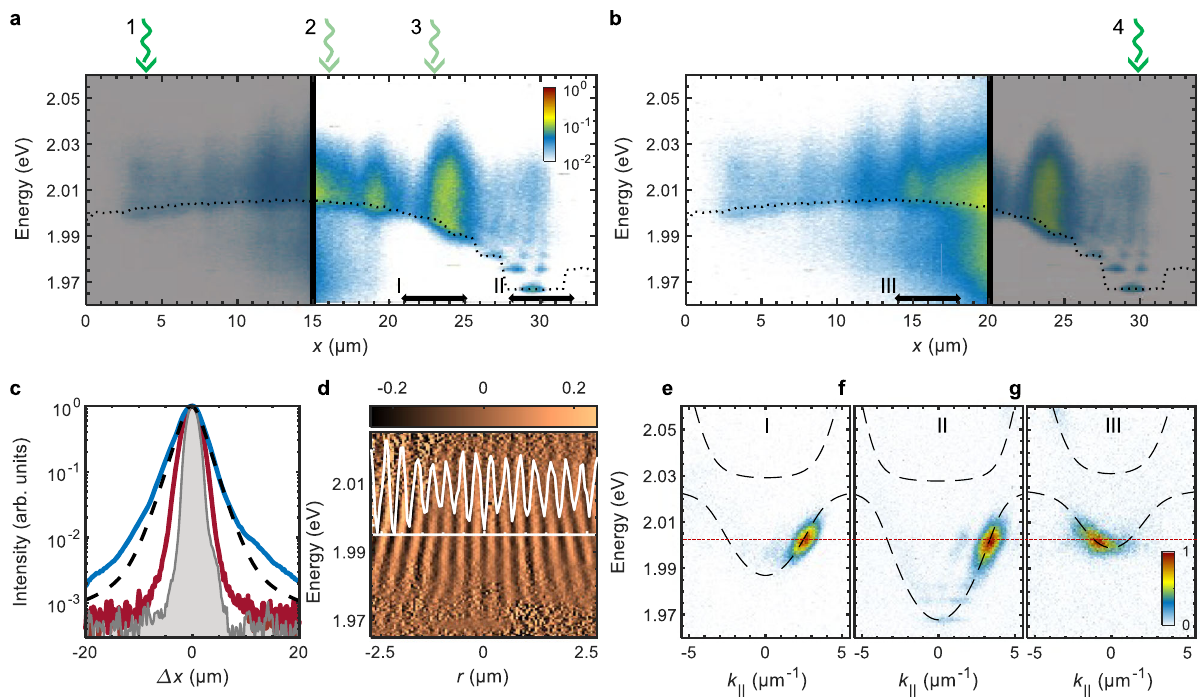
Fig. 4 Long-range polariton transport. a Position-resolved PL spectrum of the polaritons excited in the shaded area at position 1, x = 4 μ m (green arrow), and measured in the clear area at x > 15 μ m. b Position-resolved PL spectrum of the polaritons excited in the shaded area at position 4, x = 30 μ m (green arrow), and measured in the clear area at x < 20 μ m. The outline of the polariton energy at k ≈ 0, obtained by extracting spectral peak position from the signal in Fig. 2b, is marked with a dotted black line. Green (1-4) and black (I-III) arrows mark excitation and detection positions for panels c – g , respectively. c Real-space pro fi le of the laser excitation spot (grey), and the corresponding PL pro fi les of the exciton emission of a monolayer WS 2 on the DBR substrate (red), and polariton emission of the microcavity (blue), when the sample is excited at position 2. The black dashed line is the modelled PL pro fi le of the thermal polariton gas at T = 300 K (see Supplementary Fig. 4). d Normalised, spectrally resolved interferogram of the travelling polaritons in the region II, when the sample is excited at position 3. The unit of the colour bar is fringe visibility. The superimposed line plot (white) shows the normalised interference fringes at E = 1.995 eV in the range [ − 0.2, 0.2]. e , f Normalised momentum-resolved PL spectra in the detection regions ( e ) I and ( f ) II, when the sample is excited at position 2. g Normalised momentum-resolved PL spectrum in the detection region III, when the sample is excited at position 4. The spectra in e – g are measured with different spectrometer settings and acquisition times and then normalised to compare the positions of the travelling wave packets in the ( k ∣∣ ,E) parameter space rather than their intensities. The polariton dispersions (black dashed lines) in panels e , g are calculated based on the measured polariton energy at k ∣∣ ≈ 0 (Fig. 2b), the exciton energy, the Rabi splitting, and the effective mass of the cavity photon at positions I and III. The actual dispersion at position I may slightly deviate from this estimate due to variation of the cavity thickness, which leads to ~4 meV uncertainty in the kinetic energy of the propagating polaritons in e . The dispersion in panel f corresponds to the measured dispersion branches in Fig. 2d. The red dashed line in e - g marks E = 2.003